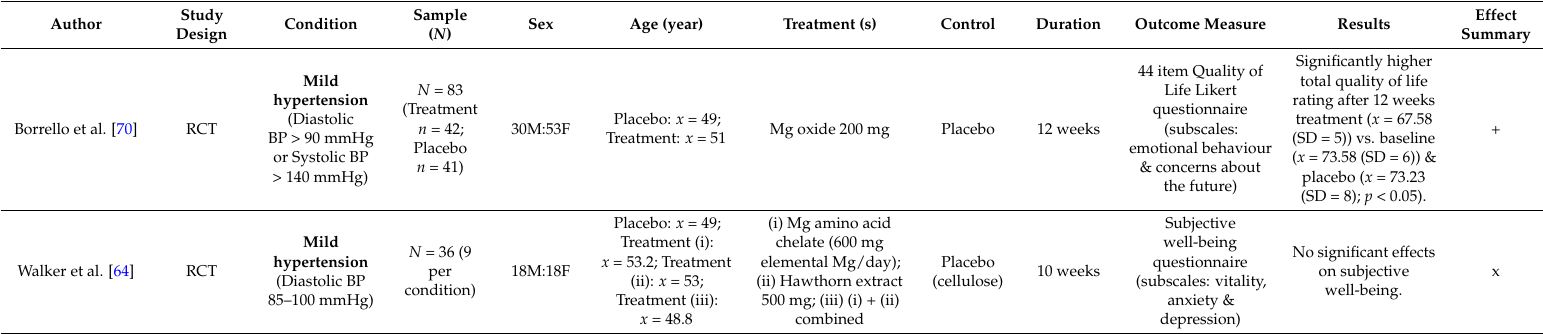
Table 4. Summary of studies reporting the effects of Mg on subjective anxiety/stress in individuals with mild to moderate